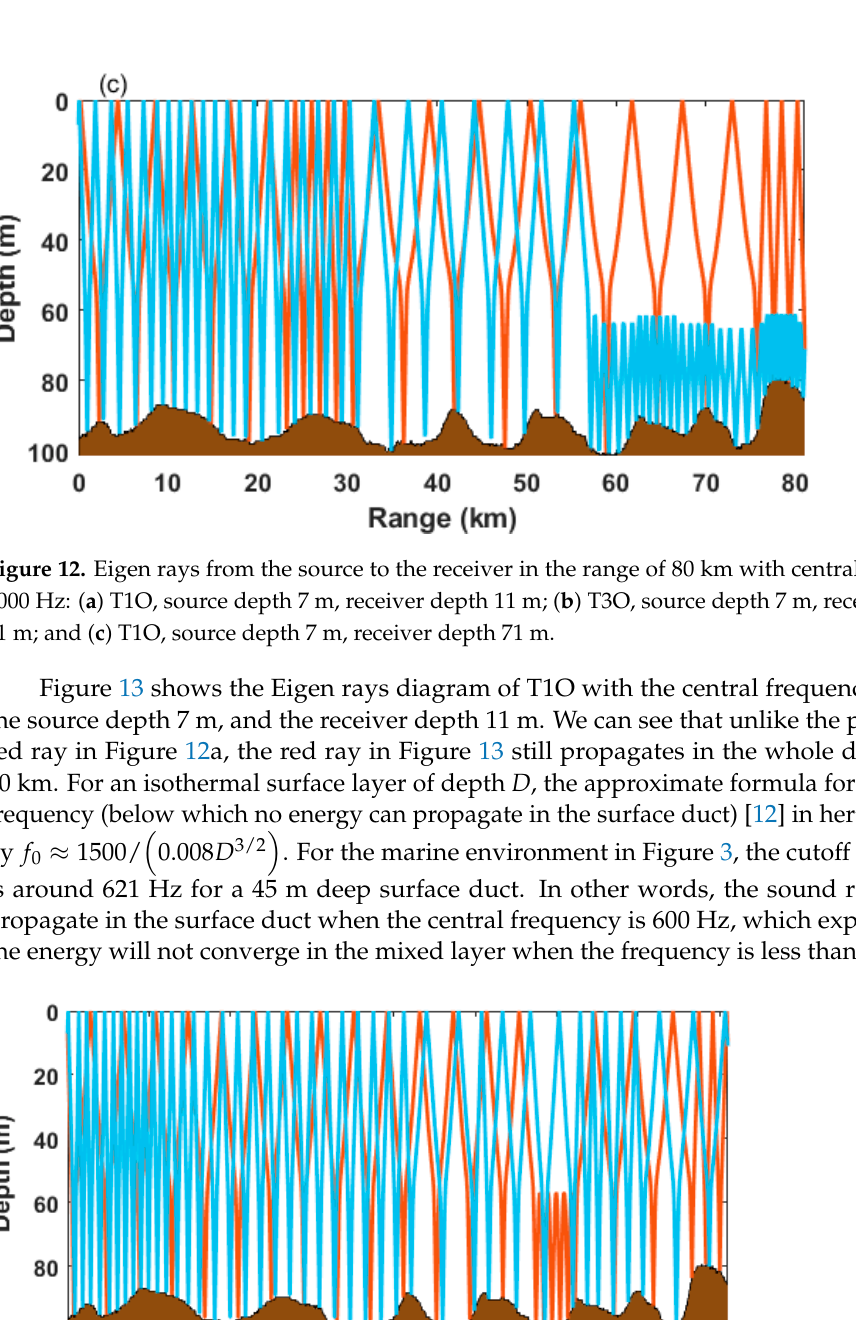
Figure 13. The Eigen rays diagram of T1O with central frequency 600 Hz, source depth 7 m, and receiver depth 11 m.